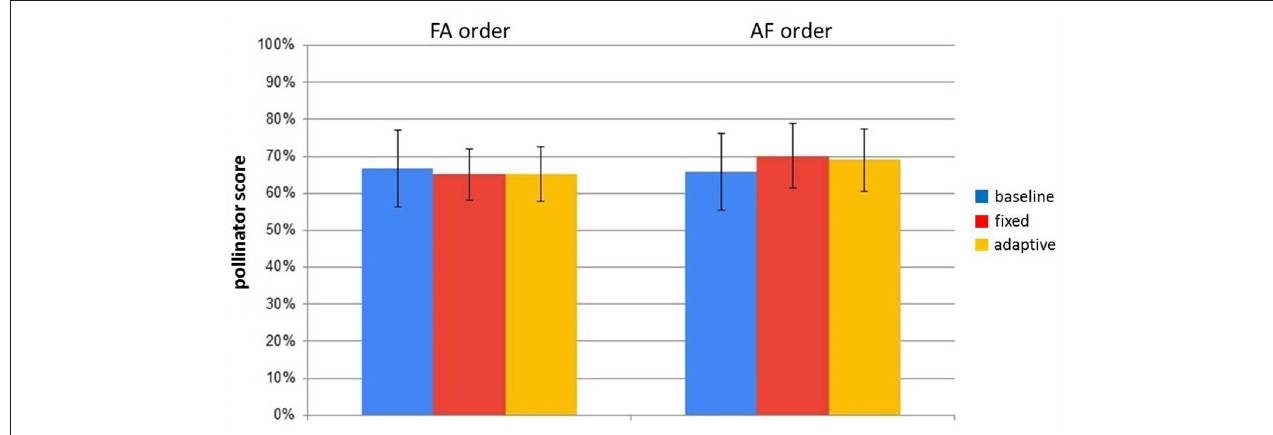
FIGURE 11 | Average pollinator scores for the three times participants did the puzzle. Error bars represent standard